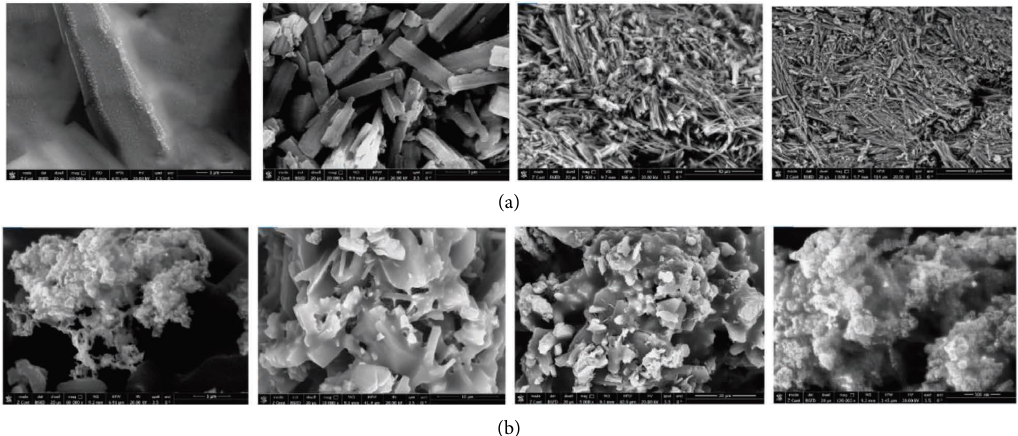
Figure 7: Scanning electron micrograph images of the (a) Cu(II)L and (b) Co(II)L